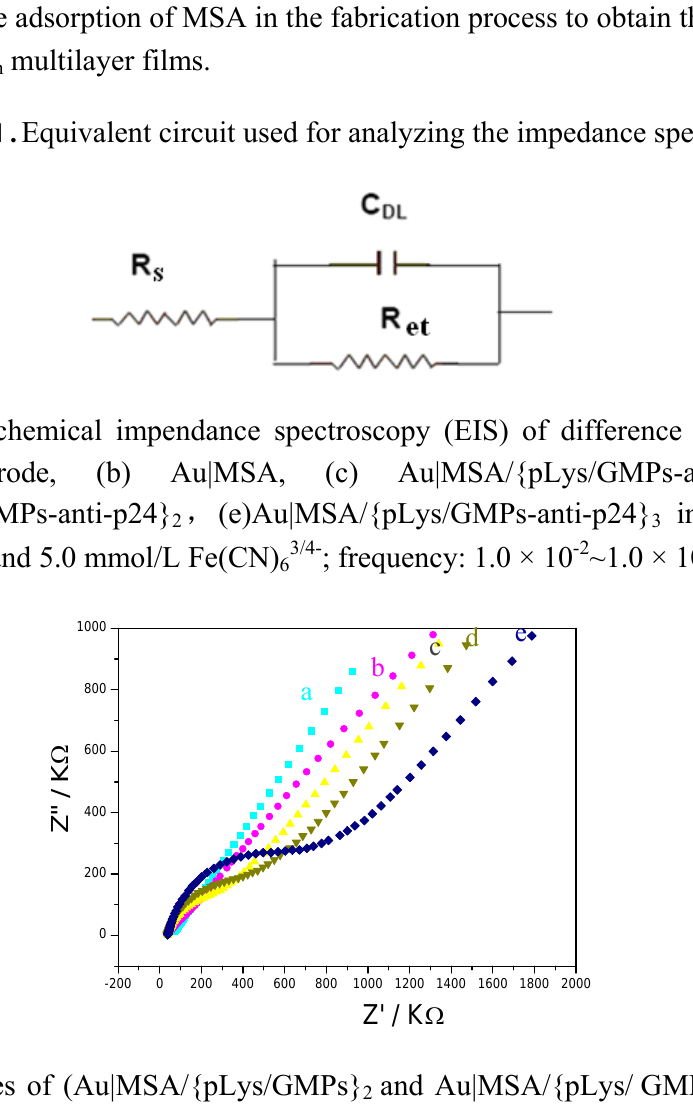
Figure 1. Equivalent circuit used for analyzing the impedance spectra.